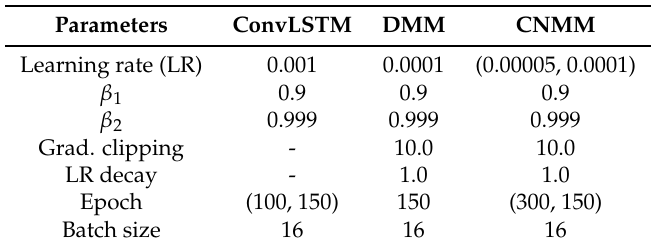
Table 4. Training specifications. (a, b) denotes the parameters used in both experiments: a shows the parameter in the heat experiment, b shows the parameter in the CMAP experiment. One value for the parameter means the value is the same across